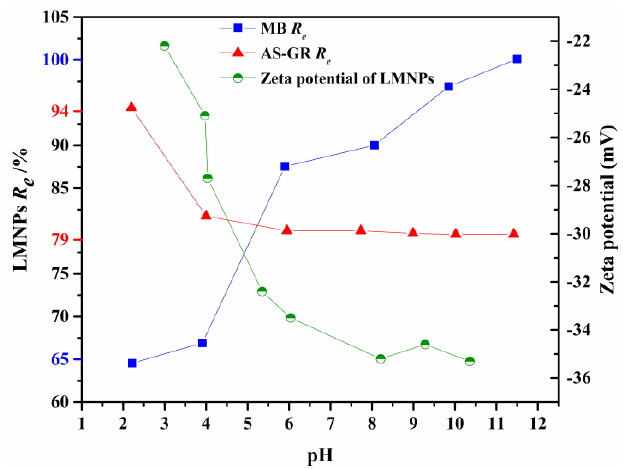
Figure 6. Removal efficiency of cationic and anionic dyes using LMNPs and zeta potential of LMNPs as a function of solution pH (the maximum and minimum removal efficiencies of MB and AS-GR are indicated as blue and red labels, respectively).